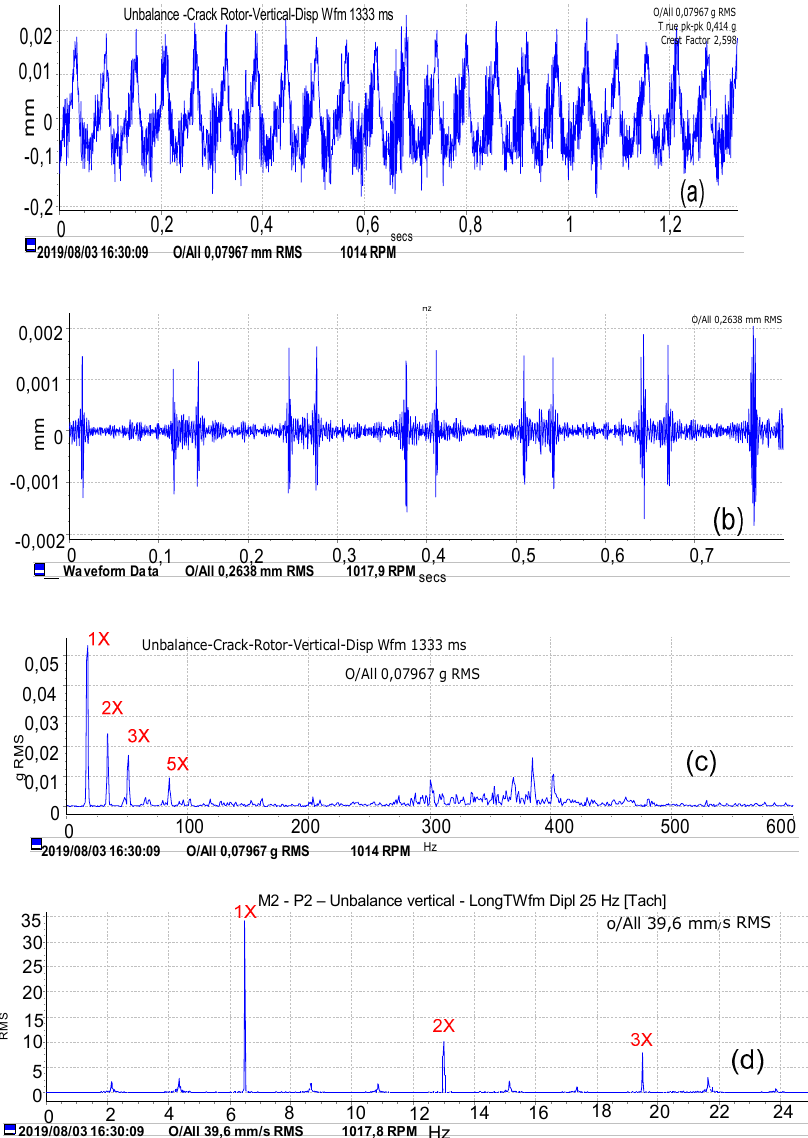
Figure 8. Experimental response of the lateral-torsional Cardan shaft: ( a , b ) lateral deflection of shaft 1 and shaft 2, and ( c , d ) frequency spectrum of the drive and driven shafts.